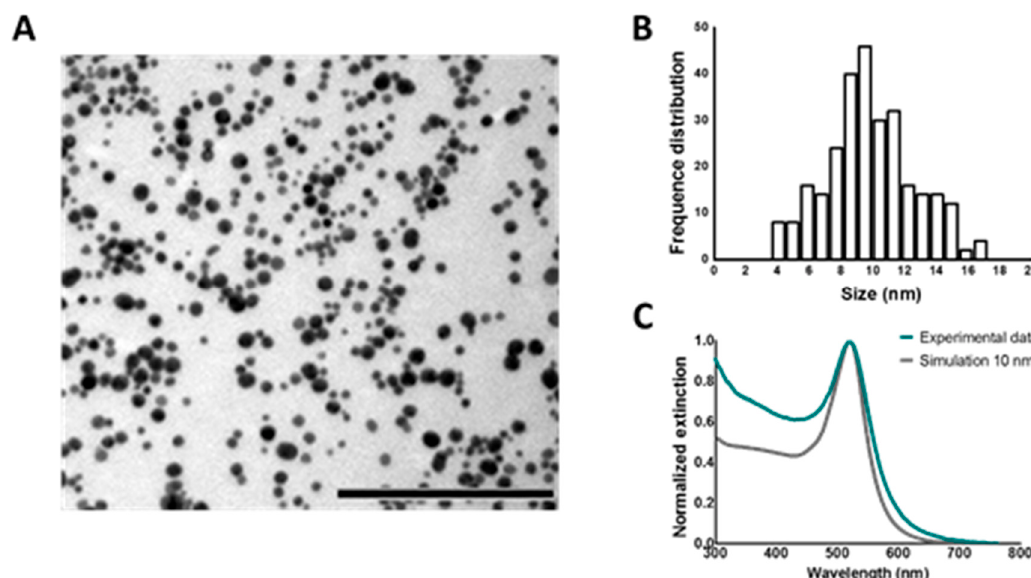
Figure 3. Characterization 10 nm AuNPs. ( A ) TEM (transmission electron microscopy) image of unfunctionalized AuNPs. Scalebar represents 200 nm; ( B ) size distribution of AuNP derived from TEM images; ( C ) normalized extinction spectrum of pristine AuNPs. The blue line represents the experimental data, as measured by UV/VIS spectrophotometry. The grey line represents the simulation of 10 nm AuNP according to the Mie theory.